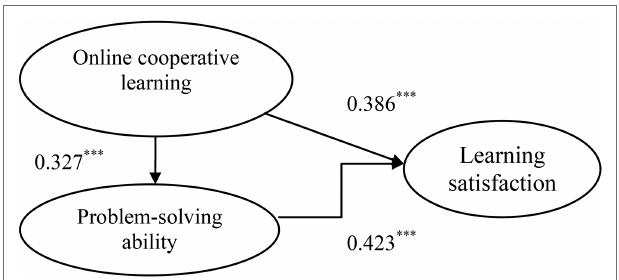
FIGURE 1 | Model path diagram. *** p <